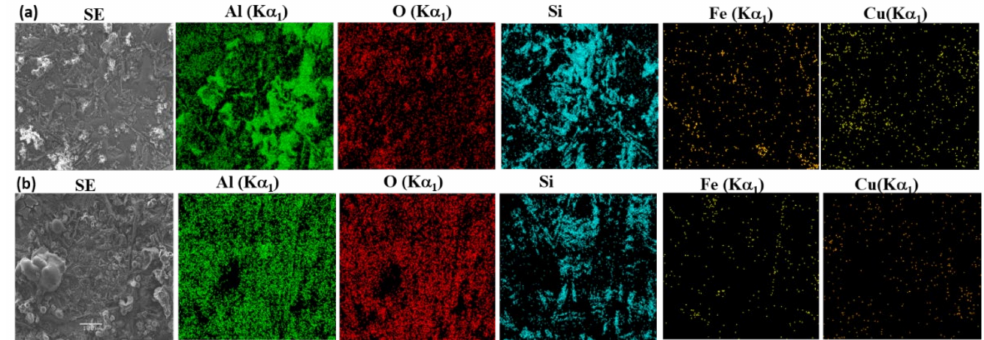
Figure 11. Element distribution mapping for Al-Si Alloy processed by sand mold ( a ) and binder jetting mold ( b ).